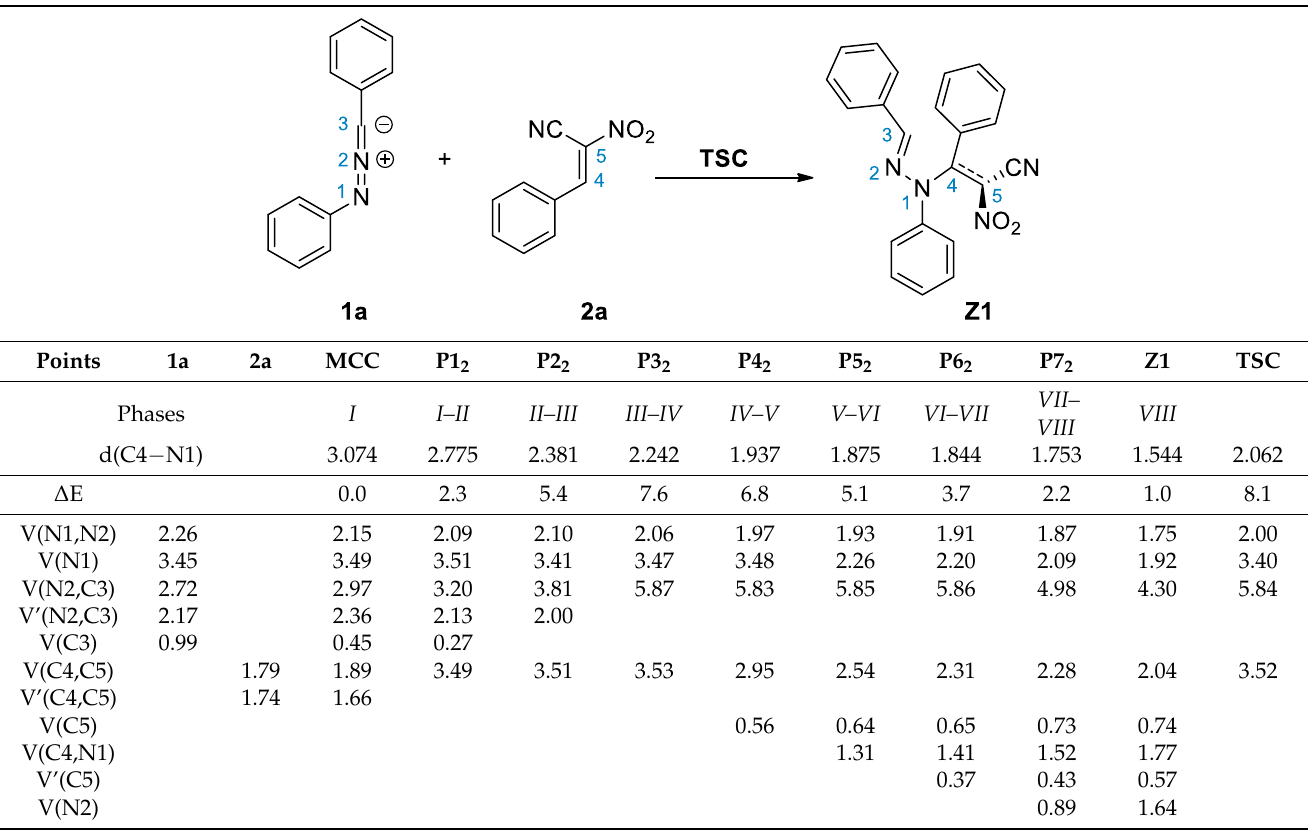
Table 7. BET analysis results for the formation of acyclic adduct Z1 . The table also lists the